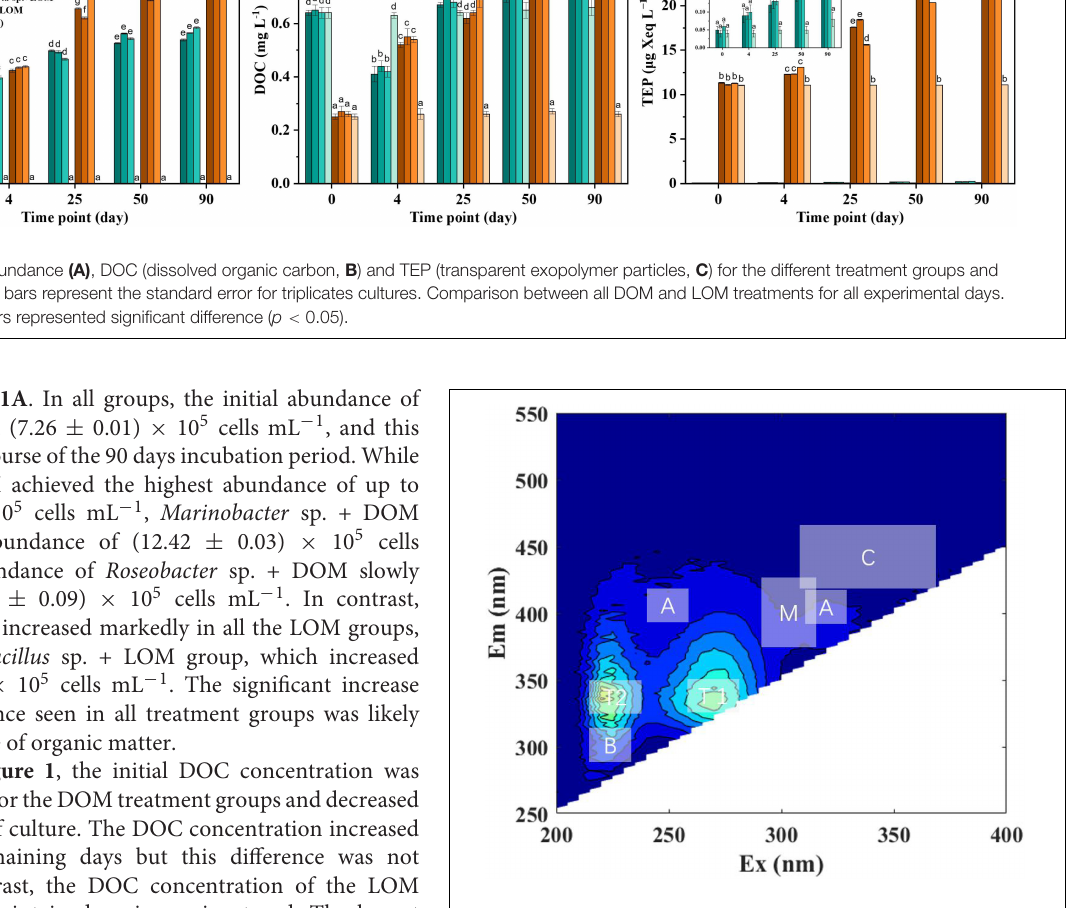
FIGURE 2 | Representative excitation-emission matrices (EEMs) of Roseobacteria sp. + DOM treatment at initial time point (day 0). Major peak regions of EEMs are indicated in the picture. The ‘A,’ ‘C,’ and ‘M’ stands for humic-like; ‘B’ and ‘T’ stands for protein-like; ‘T1’ and ‘T2’ stands for